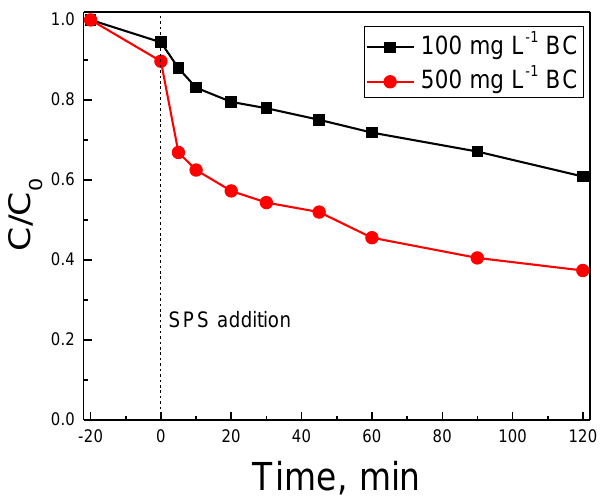
Figure 3. Effect of RHB700 dosage on 500 μg L −1 SMX degradation with 500 mg L −1 SPS in UPW and inherent pH.